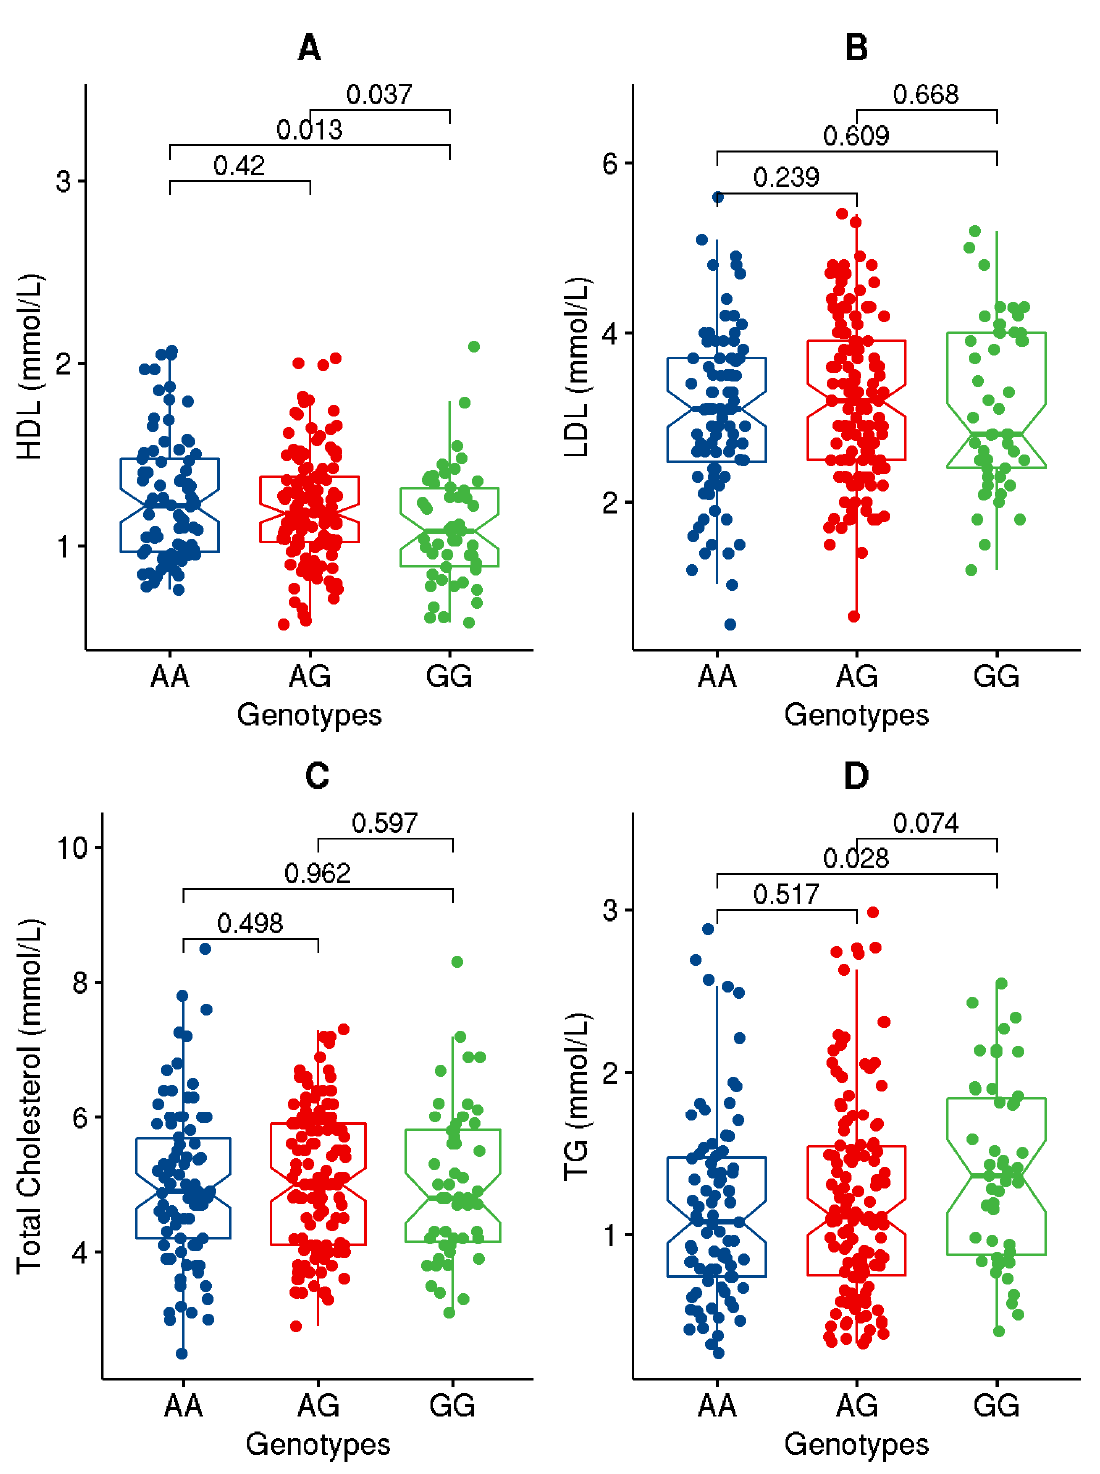
Figure 2. Data distribution for the levels of lipid traits, namely HDL ( A ), LDL ( B ), total cholesterol ( C ), and TG ( D ), in individuals with genotypes homozygous for major allele (AA) versus genotypes homozygous for effect allele (GG) or for the heterozygous genotypes (AG). The boxplot illustrates minimum and maximum values in the range, first quartile, median, and third quartile for each of the genotype